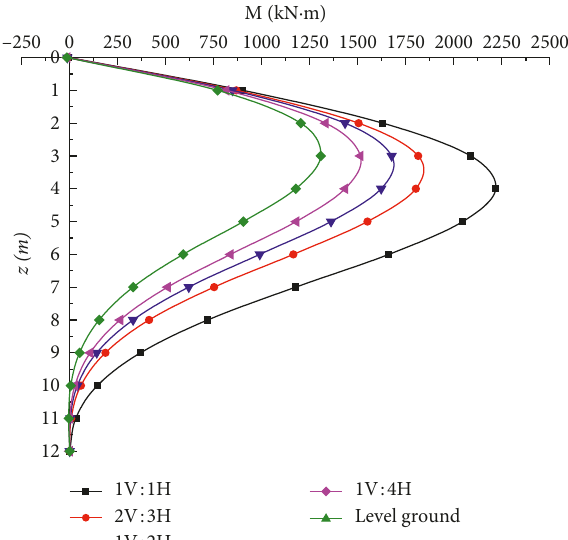
Figure 10: Bending moment of the pile versus depth relationships of different slope ratios for H 0